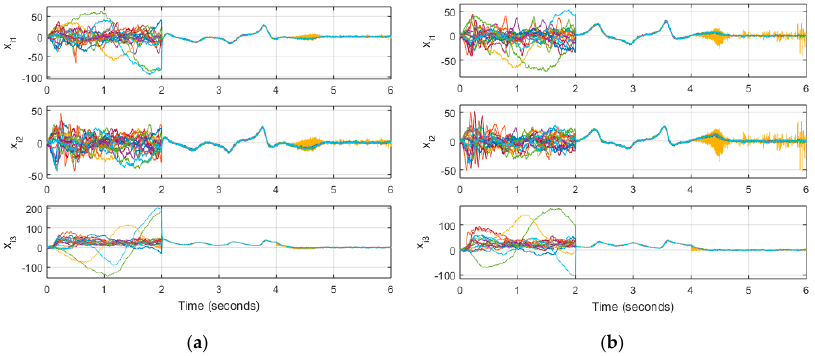
Figure 7. Complex network node dynamics when there one controller, there is noise in the system, and: ( a ) Control input is applied every 5T with control gain 𝑑 (cid:2871) (cid:3404) 1000 ; ( b ) Control input is applied every 10T with control gain 𝑑 (cid:2871) (cid:3404) 1500 .